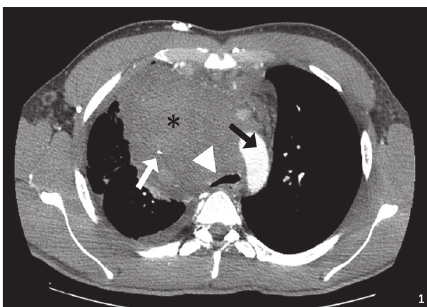
Figure 1: Contrast-enhanced computer tomography (CECT) with axial reformat shows a bulky anterior mediastinal mass (black asterisk) encasing and compressing the superior vena cava (white arrow), resulting in superior vena cava syndrome. The mass also deviates from the aortic arch (black arrow) and the trachea (white arrowhead), with a marked reduction of the tracheal